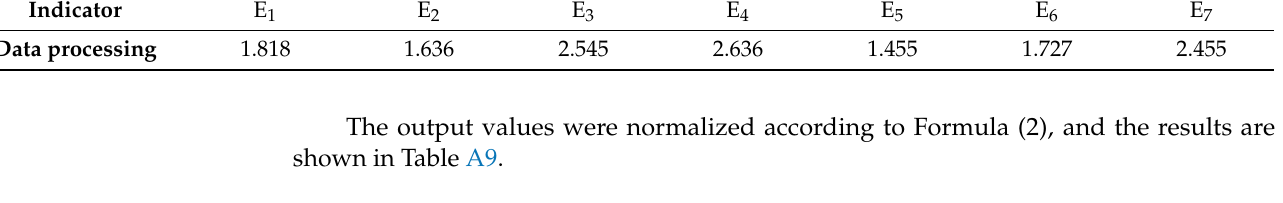
Table A9. Normalized data of environmental risk